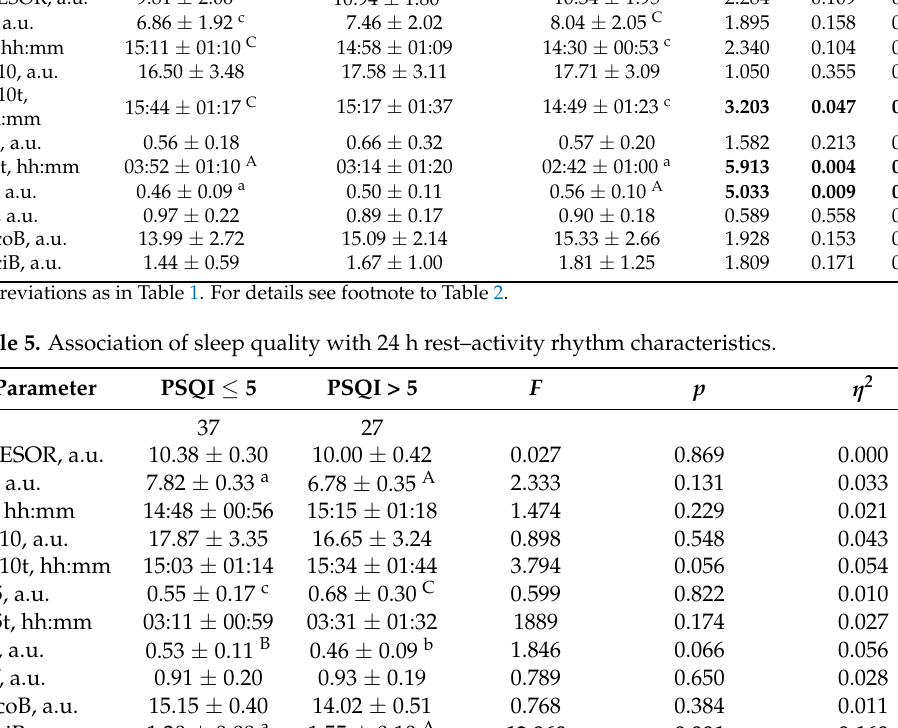
Abbreviations as in Table 1. For details see footnote to Table 2.